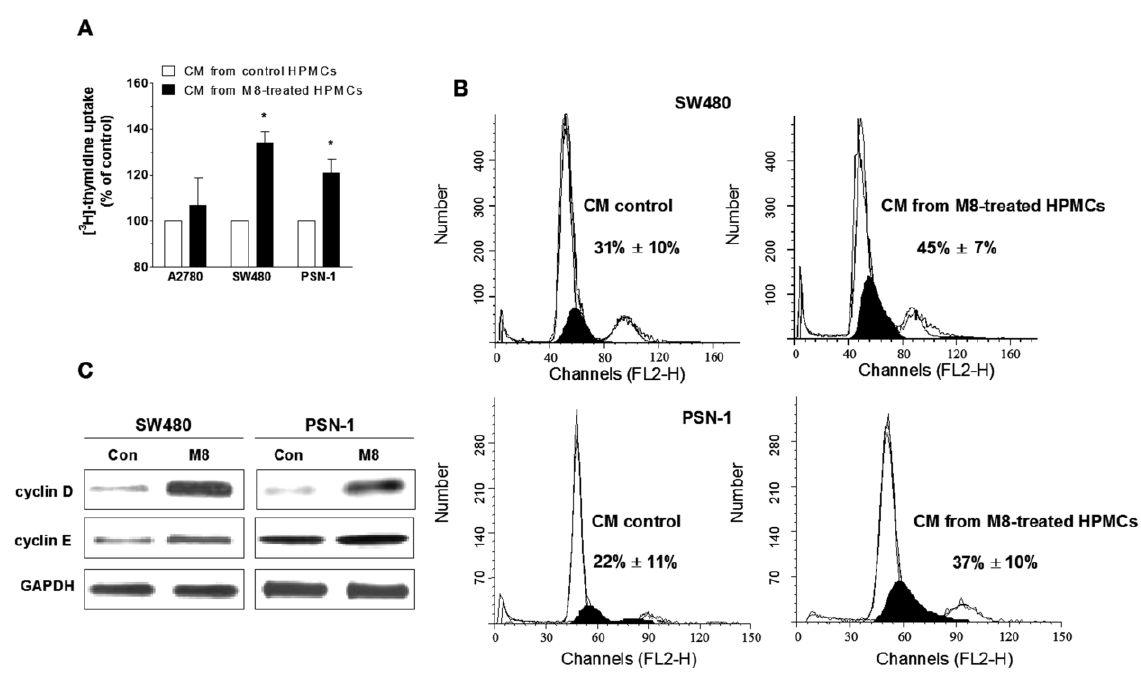
Figure 5. Effect of M8 on HPMC-dependent proliferation of ovarian (A2780), colorectal (SW480), and pancreatic (PSN-1) cancer cells. Cell proliferation was assessed on low-density cultures exposed for 24 h to the conditioned medium harvested from HPMCs that senesced prematurely in response to 10 μM M8 and to the medium from the control cells (from the same passage), using [ 3 H]-thymidine incorporation assay ( A ); The measurements of cancer cell distribution within the cell cycle, in particular in the S phase (darkened area) ( B ); The values shown in the panel ( B ) indicate the size of cell fraction in the S phase, in the cultures exposed to CM (conditioned medium) from control HPMCs and to CM from HPMCs prematurely senesced in response to 10 μM M8, respectively. The representative results of western-blot analysis of cell cycle regulators: cyclins D and E. Bands corresponding to target molecules were compared to those for GAPDH ( C ). The asterisks indicate a significant difference compared to the control cells treated as 100%. The experiments were performed in quadruplicates with CM from HPMC cultures obtained from 5 different